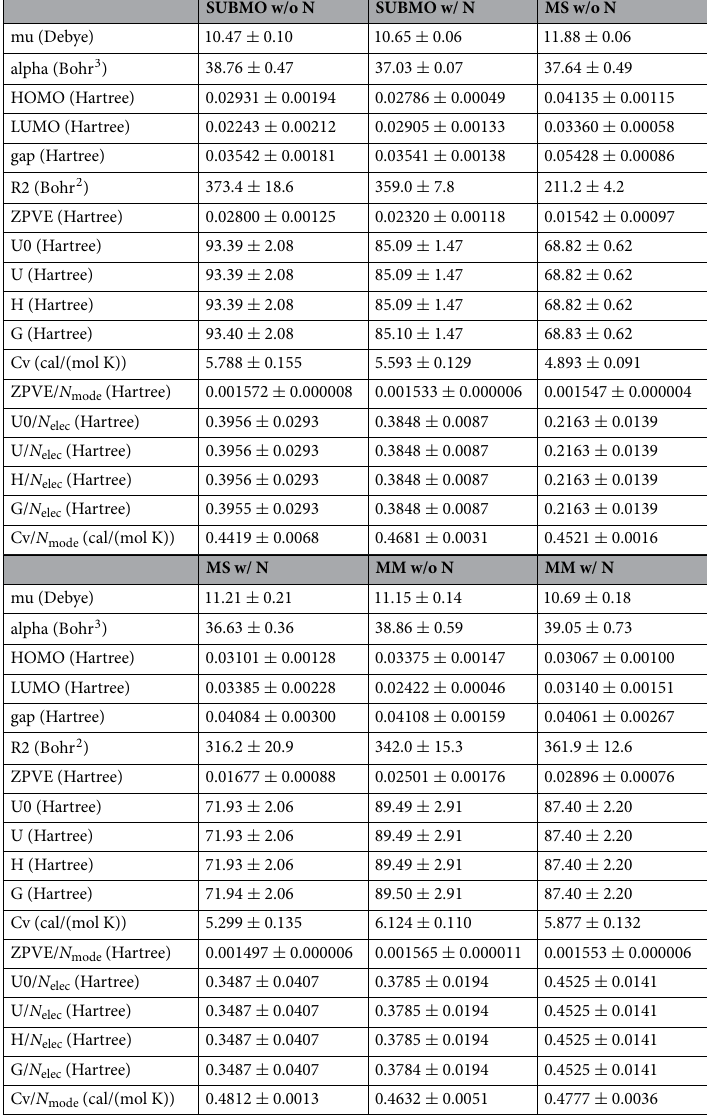
Table 5. WDUD values in the ablation study. Since the GNN-based vector-generation process has randomness, the results of all methods are shown by means and standard deviation over five